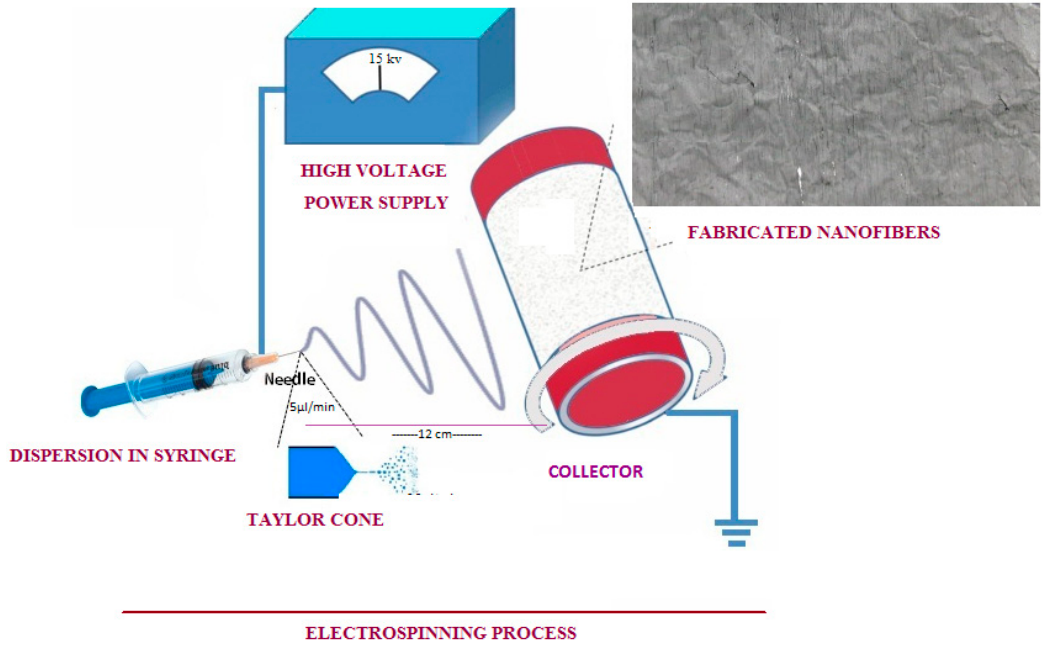
Figure 1. Schematic illustration of the process of electro-spinning utilized for the fabrication of nanofibers. of